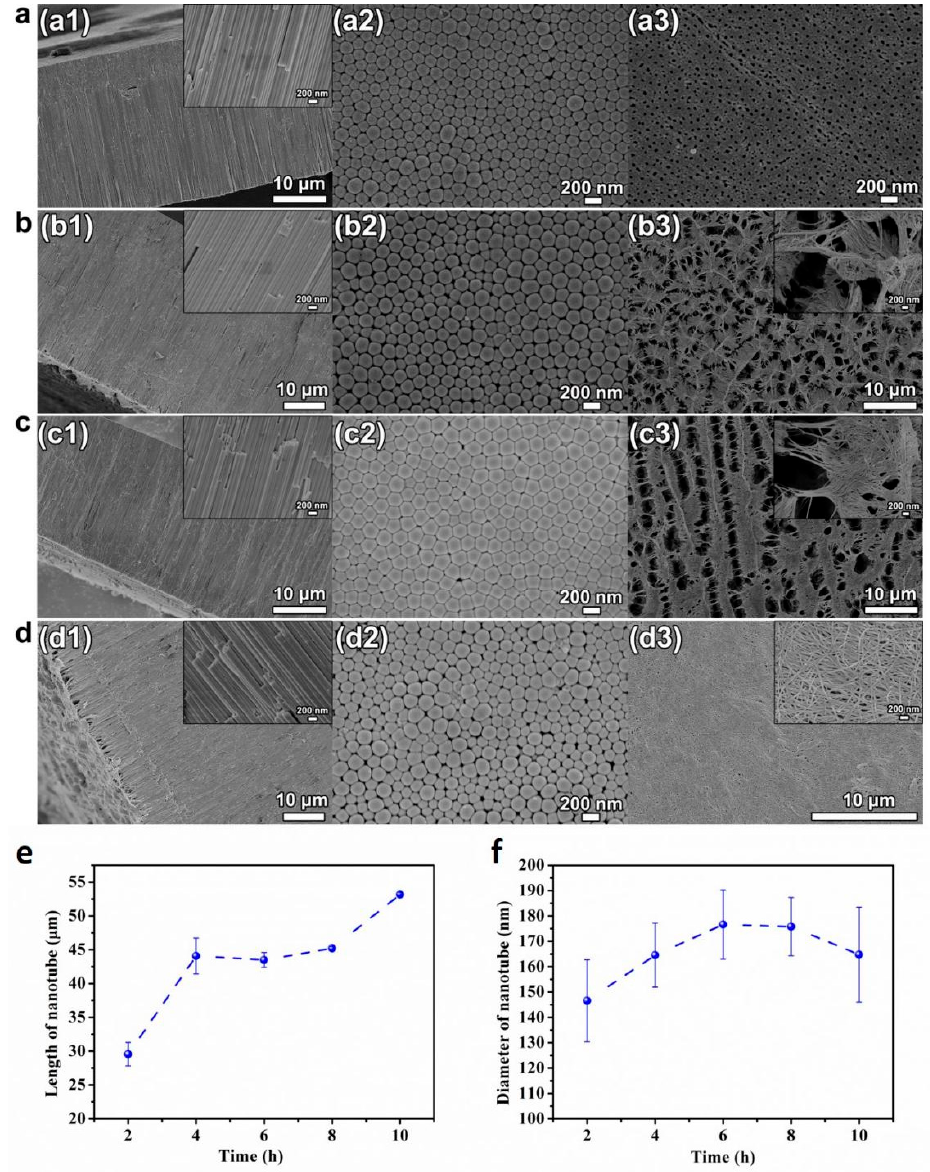
Figure 3. ( a – d ) SEM images of cross-sectional ( a1 – d1 ), bottom ( a2 – d2 ) and top view ( a3 – d3 ) of the HEO nanotube arrays formed under 60 V in the ethylene glycol solution containing 0.1 mol/L NH 4 F and 10 vol.% of water after different anodization times, ( a ) 2 h, ( b ) 6 h, ( c ) 8 h, and ( d ) 10 h; ( e ) The changes in nanotube length and diameter ( f ) with anodization time.